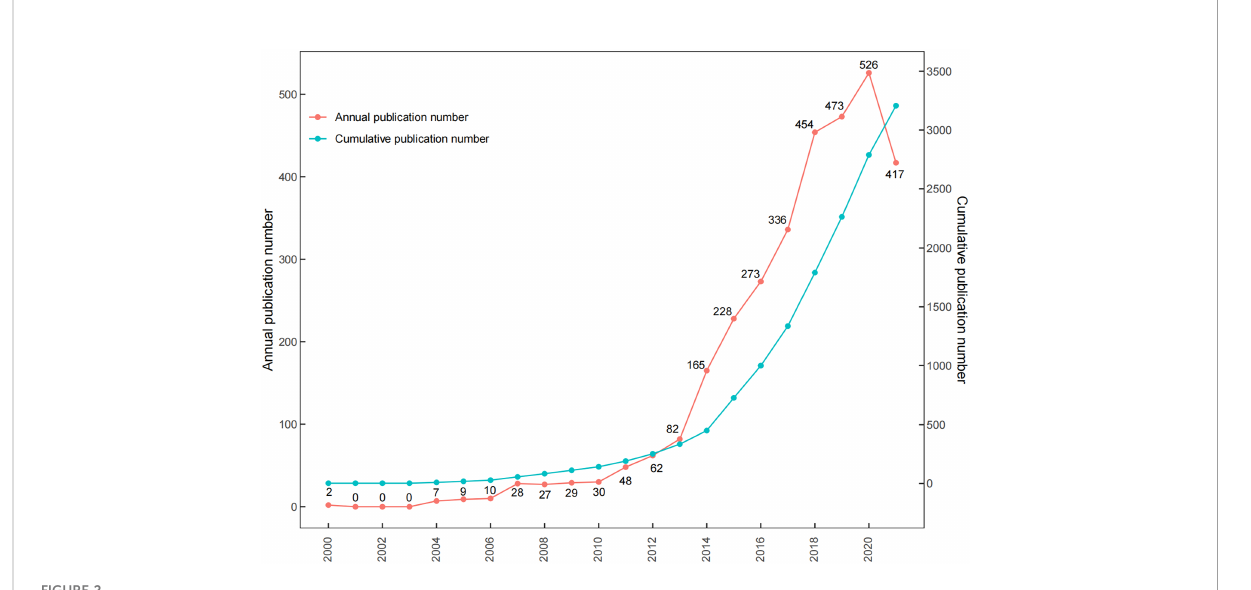
FIGURE 2 The numbers of annual and cumulative